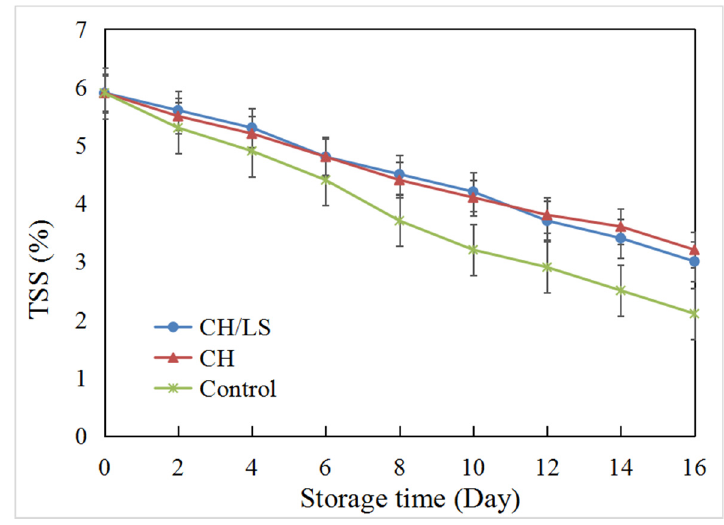
Figure 4. The Soluble solids of grapes during preservation with different packaging films.